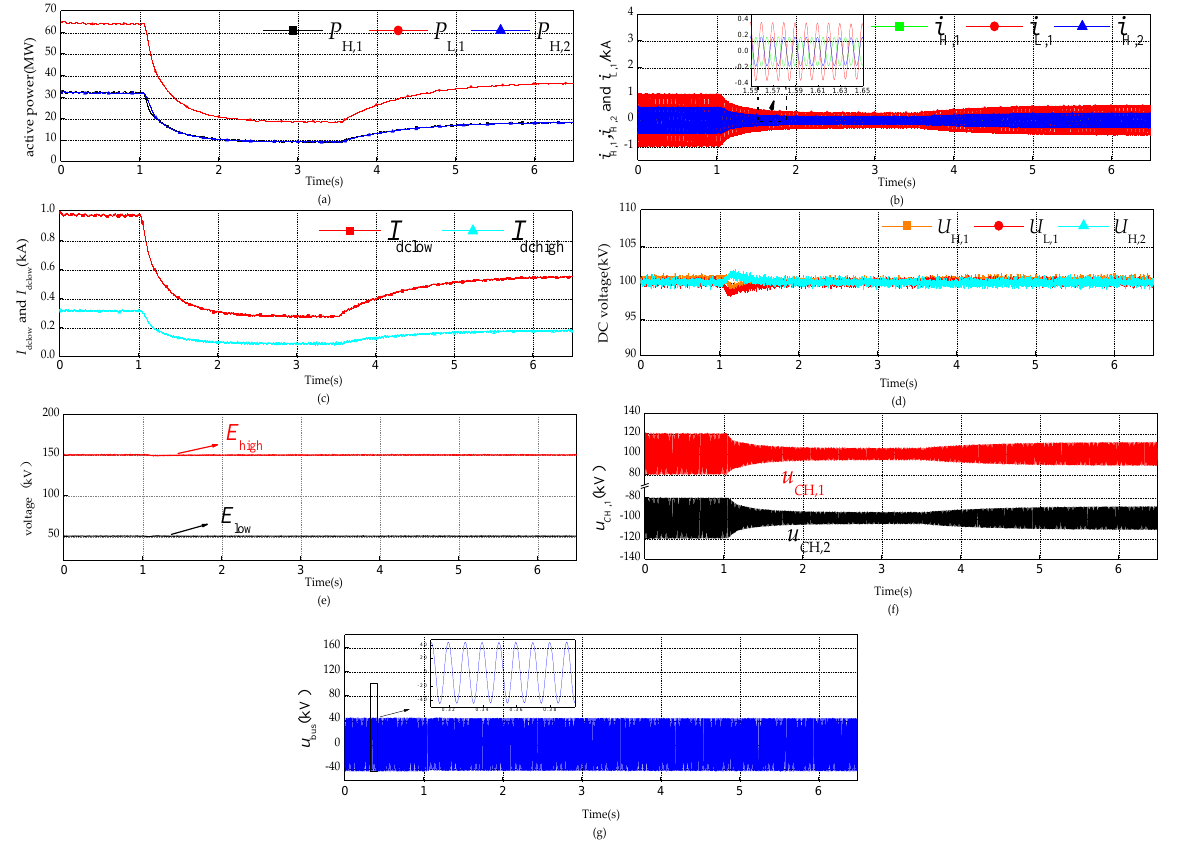
Figure 6. Simulation results of wind speed variation: ( a ) Active power transmitted by the MCAT; ( b ) A phase AC output current of MMCs; ( c ) DC currents of high-voltage and low-voltage DC grids respectively; ( d ) DC voltages of MMCs; ( e ) DC voltages of high-voltage and low-voltage DC grids respectively; ( f ) voltages of C H,1 and C H,2 ; ( g ) A phase AC voltage of the AC